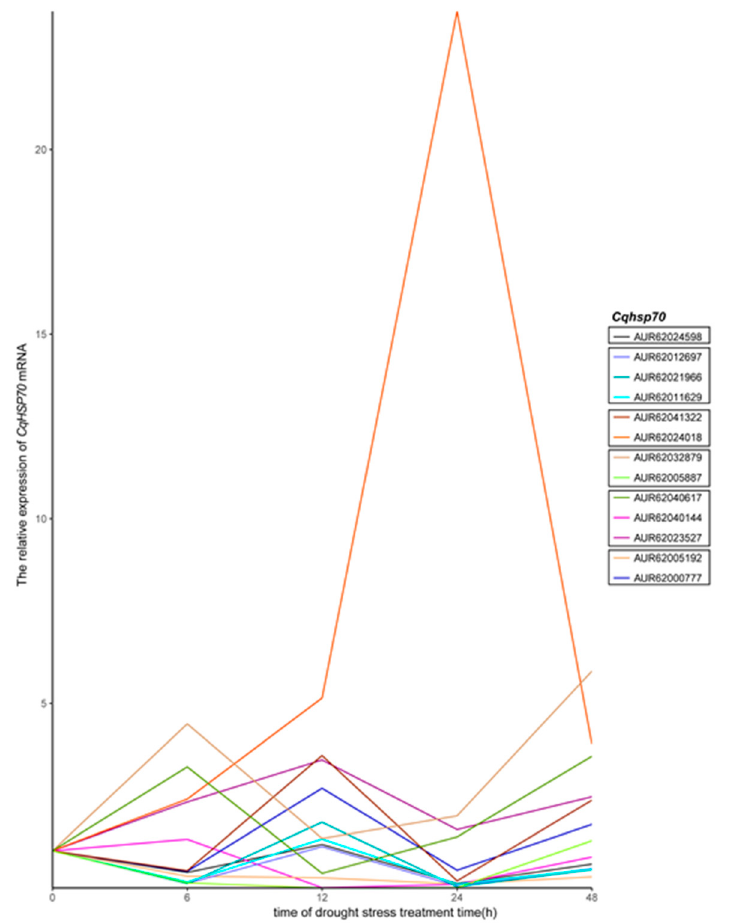
Figure 6. Cqhsp70 s gene expression profiles in response to drought treatment. Two-week-old quinoa seedlings were irrigated with 25% PEG6000 ( w / v ) for drought stress. Above-ground tissues were collected at five time points (0, 6, 12, 24, and 48 h) during the treatments. Quantitative polymerase chain reaction (qPCR) assays were performed with different batches of treated plants and one representative data was shown.